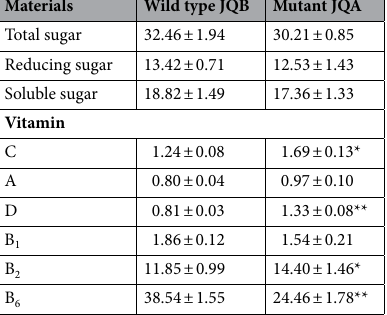
Table 4. Total sugar, reducing sugar, total soluble sugar, and vitamins contents in sesame leaves (mg/g). Values are means ± standard deviation ( n = 3). Data in the same row followed by * and ** are significantly ( P < 0.05) and very significant ( P < 0.01) different, respectively.